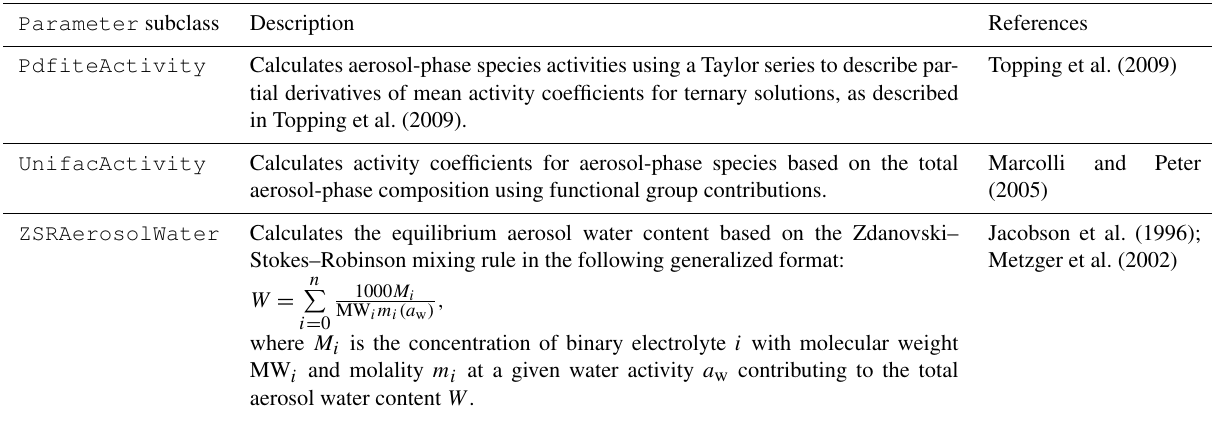
Table 4. Current implementations of the Parameter base class. These are included here for reference and will be described in more detail and evaluated in a separate